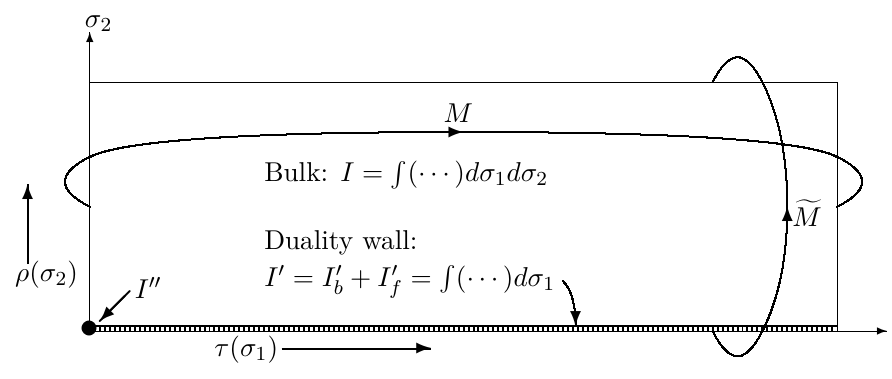
Figure 1 . Our field theory is defined on a T 2 parametrized by 0 ≤ σ 1 , σ 2 ≤ 1 , with τ varying as a function of σ , and ρ varying as a function of σ 1 the geometrical M ∈ SL(2 , Z ) ] and σ intersection supports a 0d action I 00